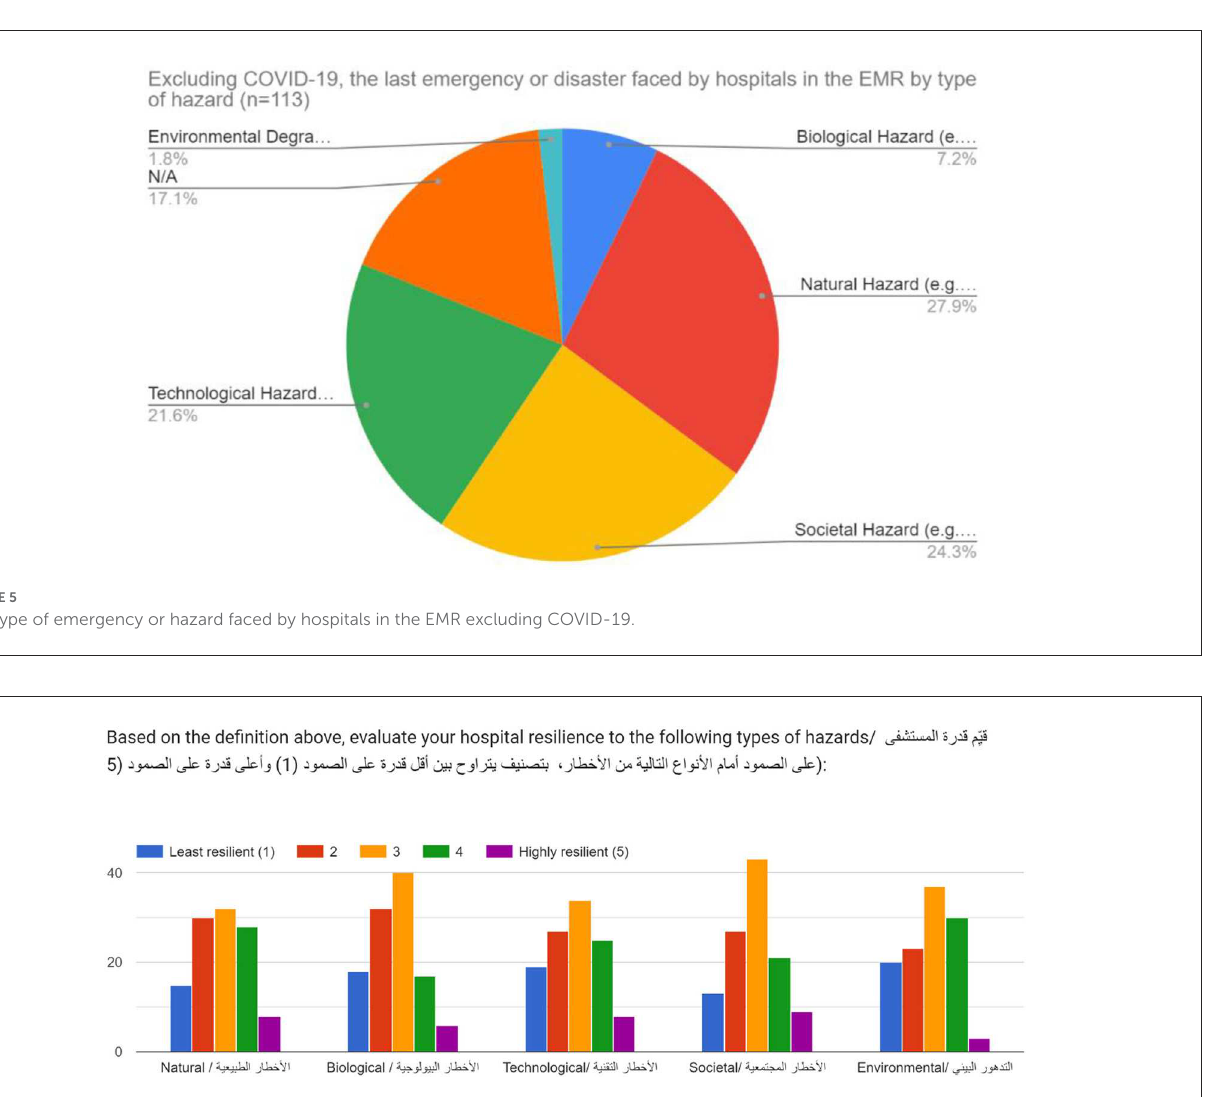
FIGURE6 Five-point Likert-scale evaluation of hospital resilience by type of